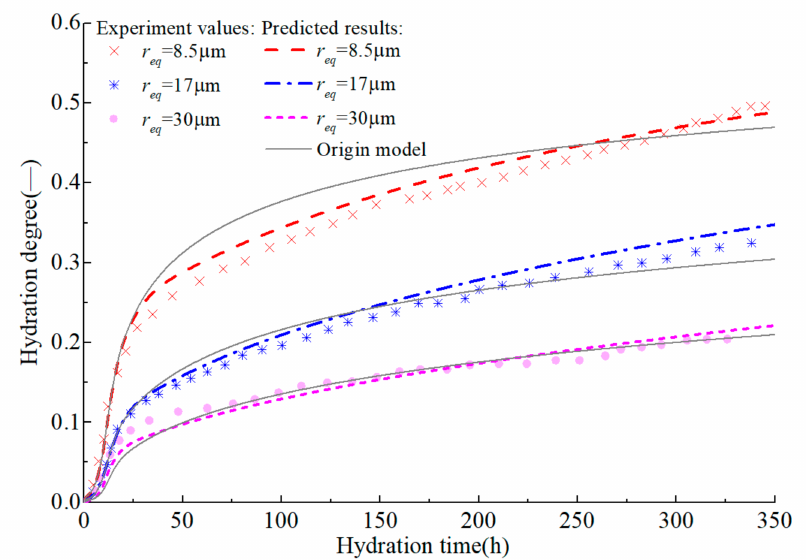
Figure 6. Test values and prediction curves of hydration degree of alite in middle age.